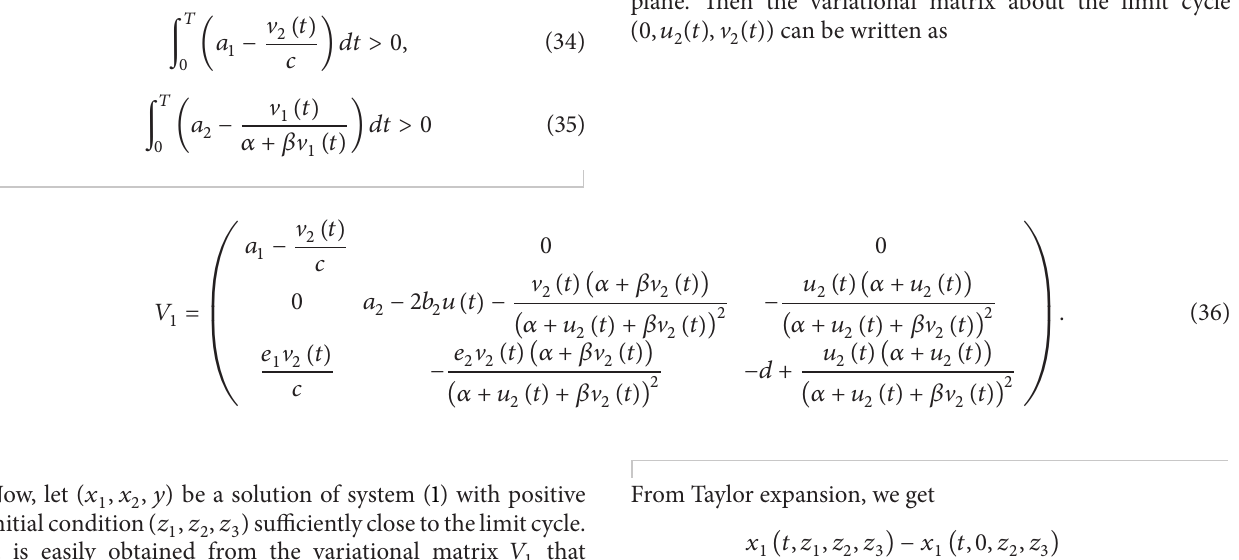
shows a phase portrait and time series of all species of system (1) with initial condition (0.7, 0.3, 0.7)